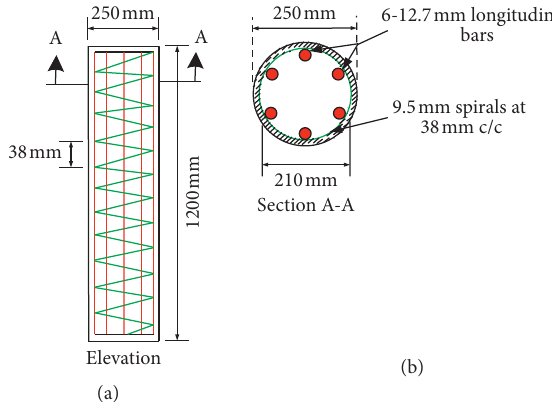
Figure 1: Drawings of a column with a spiral pitch of 38mm.